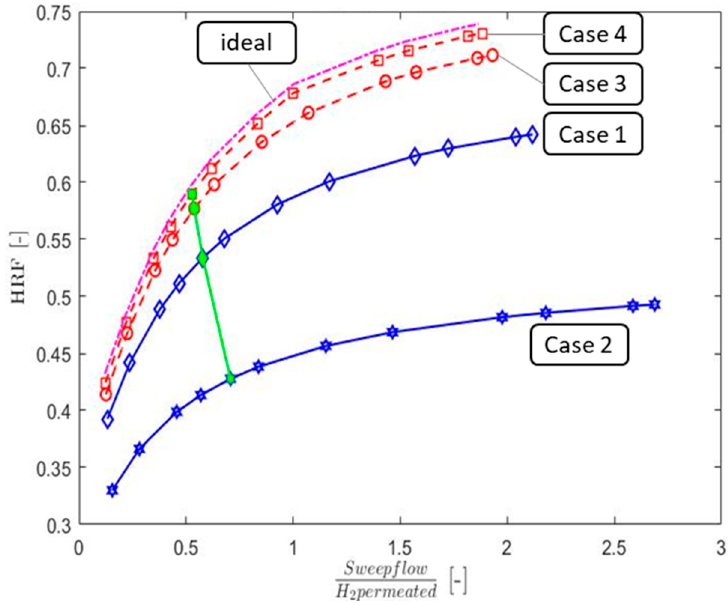
Figure 5. Porosity over tortuosity (left side) and pore size (right side) effects on HRF.